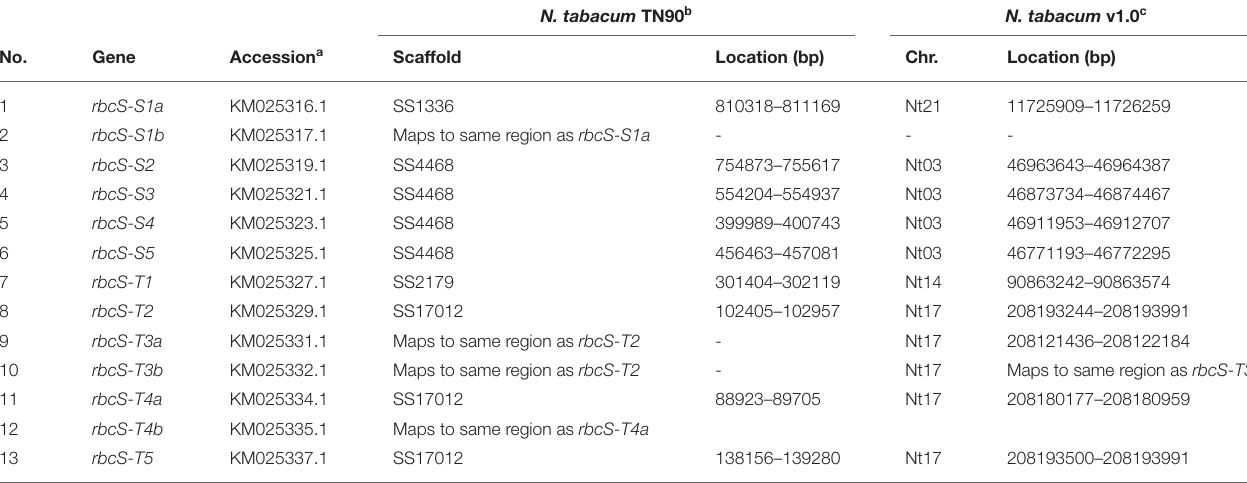
TABLE 1 | Genomic locations of thirteen Rubisco small subunit genes in